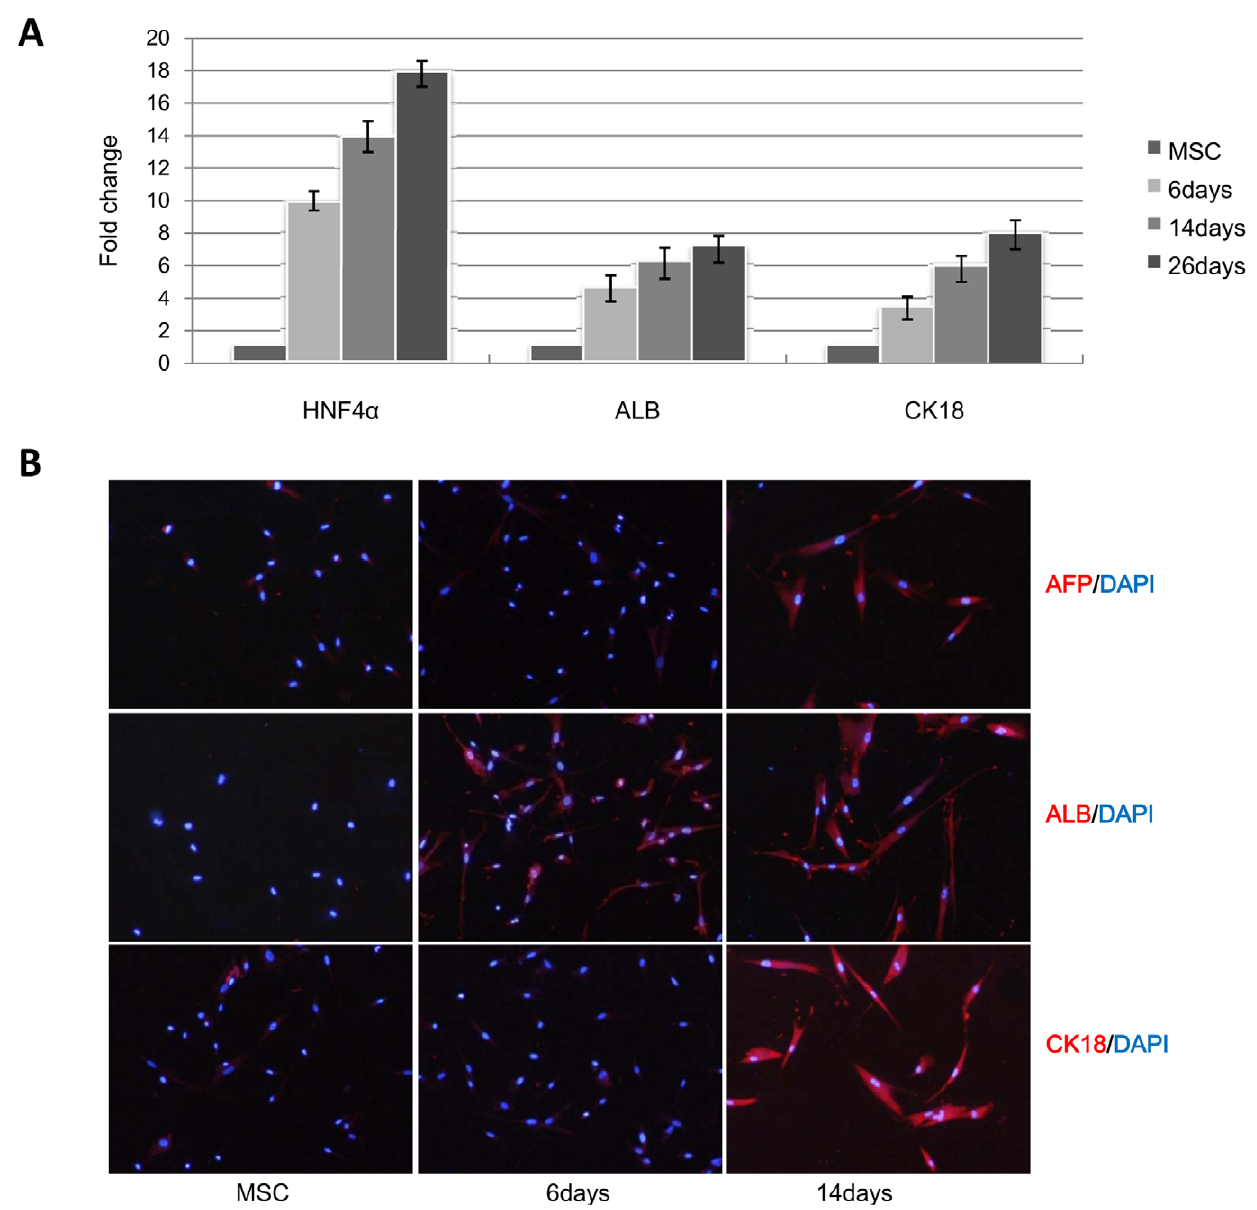
Figure 1. Hepatic differentiated hUC-MSCs can express hepatocyte–specific genes. A: Hepatocyte-specific gene expression analyzed by qRT-PCR in hUC-MSCs and hepatic differentiated hUC-MSCs for 6 days, 14 days and 26 days. Hepatocyte-specific gene expression was normalized to GAPDH expression, and the results are expressed relative to a value of 1 in the control hUC-MSCs. B: immunofluorescence of hepatocyte-specific gene expression in MSCs and hepatic differentiated MSCs. After induction for 14 days, hUC-MSCs can express AFP, ALB and CK18.